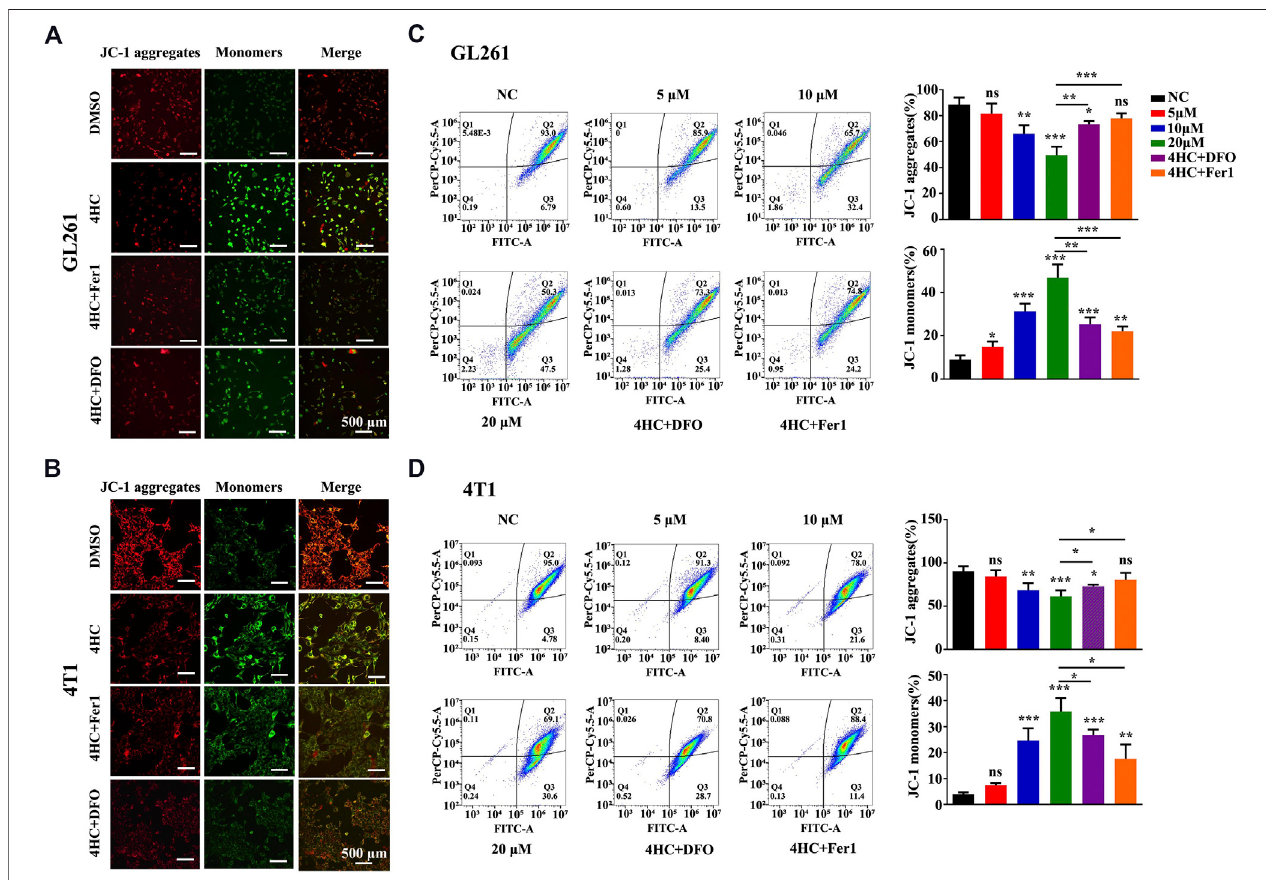
FIGURE 4 | Ferroptosis inhibitors reversed the 4HC-induced decrease of the mitochondrial membrane potential. (A – B) Images of JC-1 staining in 4HC-treated GL261 and 4T1 cells cultured in the presence or absence of Fer1 and DFO. Shown were representative images with similar results (scale bar = 500 μ m). (C – D) Determination and fl ow cytometry analysis of the MMP in tumor cells treated under the indicated conditions. Values are presented as the means ± SD from more than three independent experiments. ns, not signi fi cant, * p < 0.05, ** p < 0.01, and *** p < 0.001 (one-way ANOVA analysis) for the indicated comparisons.